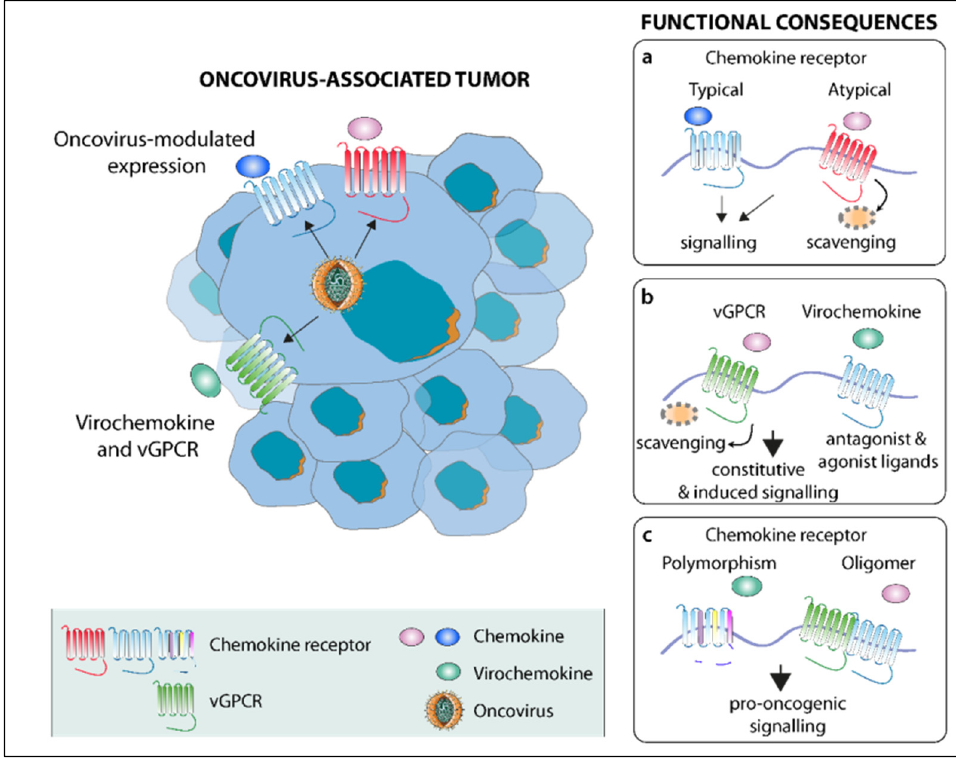
Figure 1. Interplay between oncoviruses and the chemokine system. By modulating the expression of chemokines and their receptors and encoding for viral homologs (left part), oncoviruses can ham- per the functioning of chemokines and their typical and atypical human receptors through ( a ) in- creased activation or aberrant signaling; ( b ) virochemokines (e.g., vCCL-1-3) and vGPCRs (e.g., ORF74) acting as ligands and receptors of their human homologs, respectively; and ( c ) GOF mutants of human receptors (e.g., CXCR4) or potential oligomers formed between vGPCRs and human re- ceptors (e.g.,